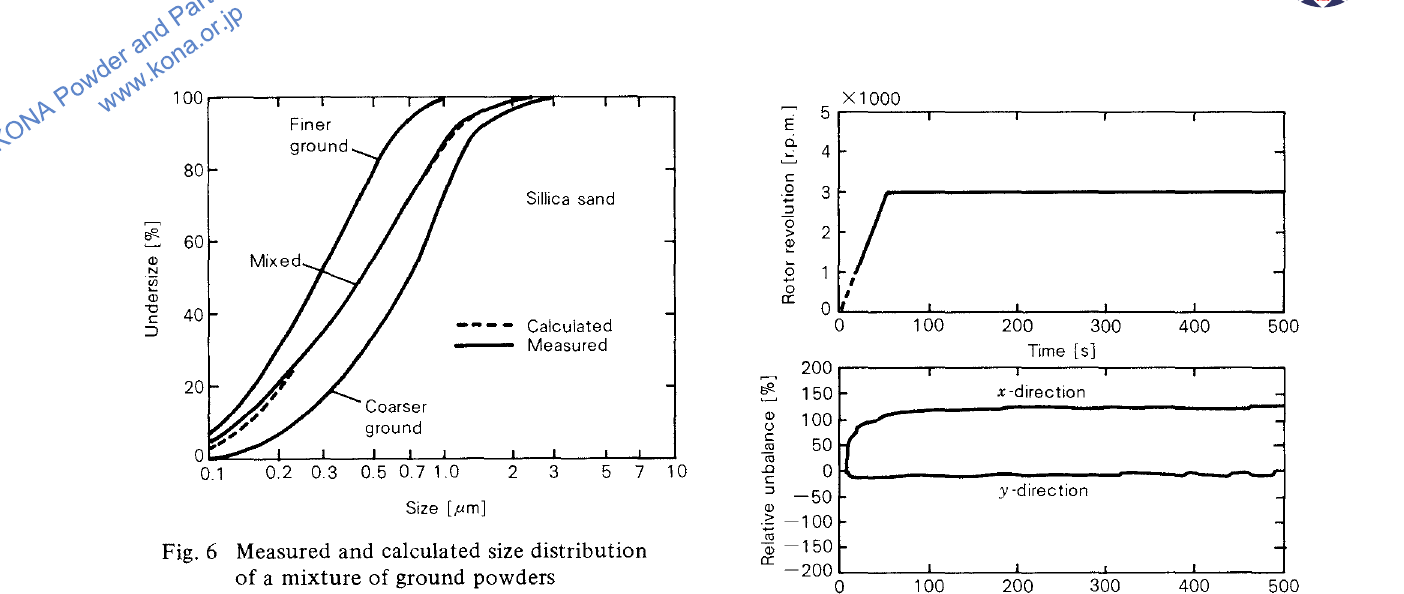
Fig. 6 Measured and calculated size distribution of a mixture of ground powders